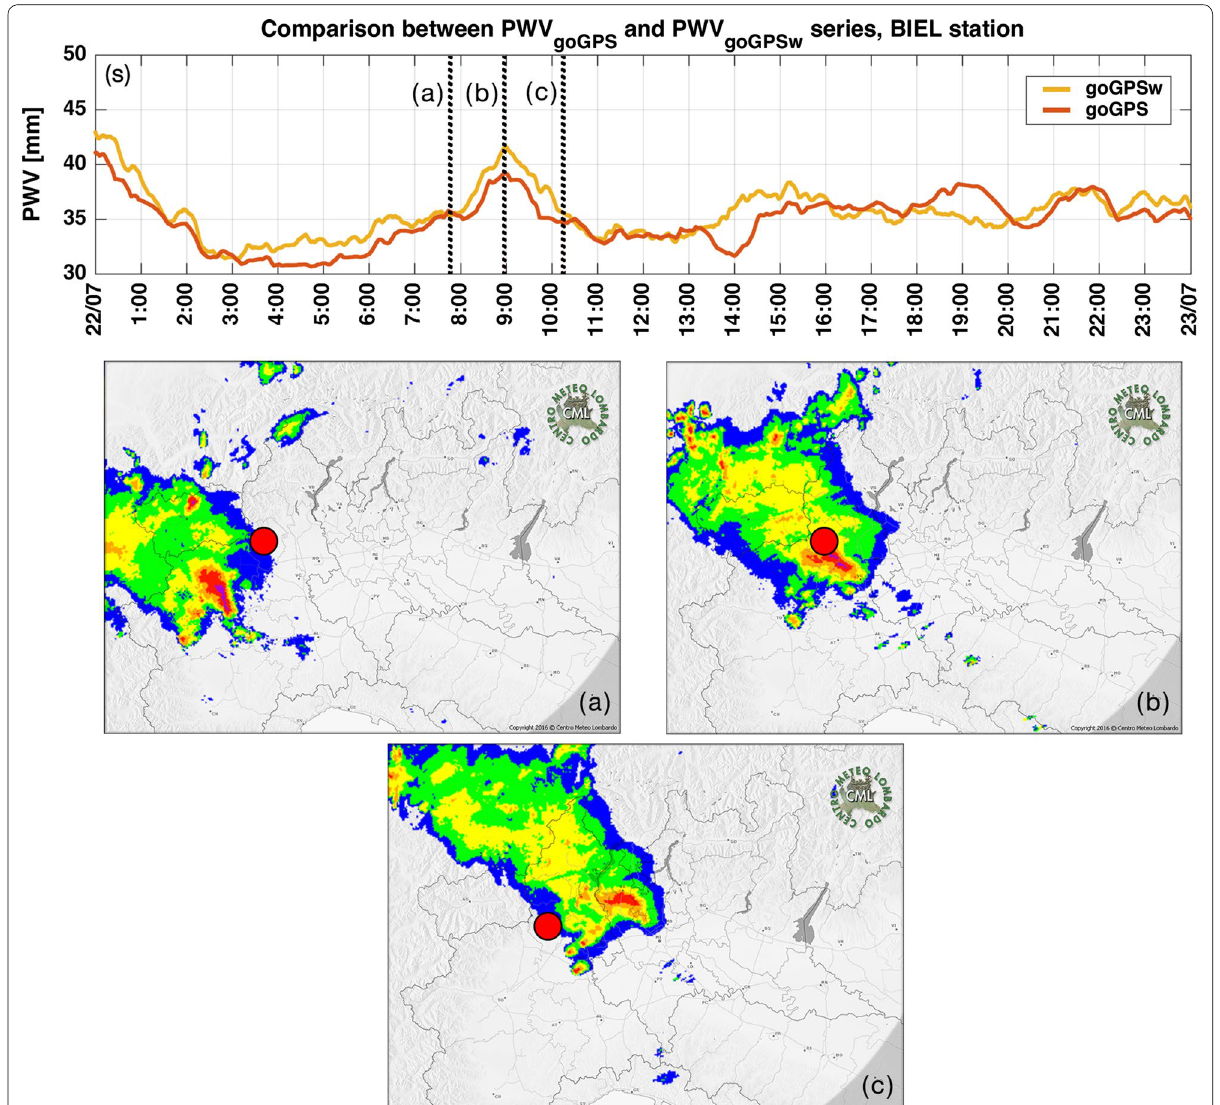
Fig. 7 In the subfigure(s), the BIEL station PWV goGPS and PWV goGPSw time series. On the bottom, radar images corresponding to a the epoch when the precipitation starts passing over the station, b to the epoch when it completely surrounds the station, and c to the epoch when it starts leaving the station